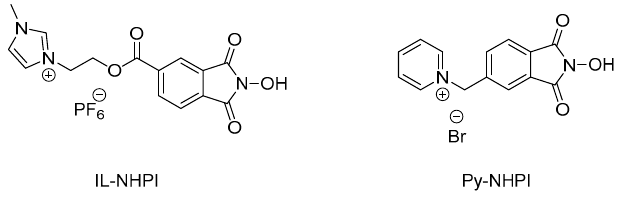
Figure 2. NHPI immobilized in ionic liquids.